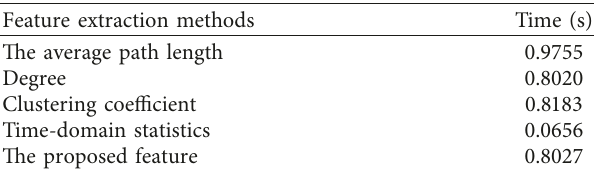
Table 4: Average running times of different feature extraction